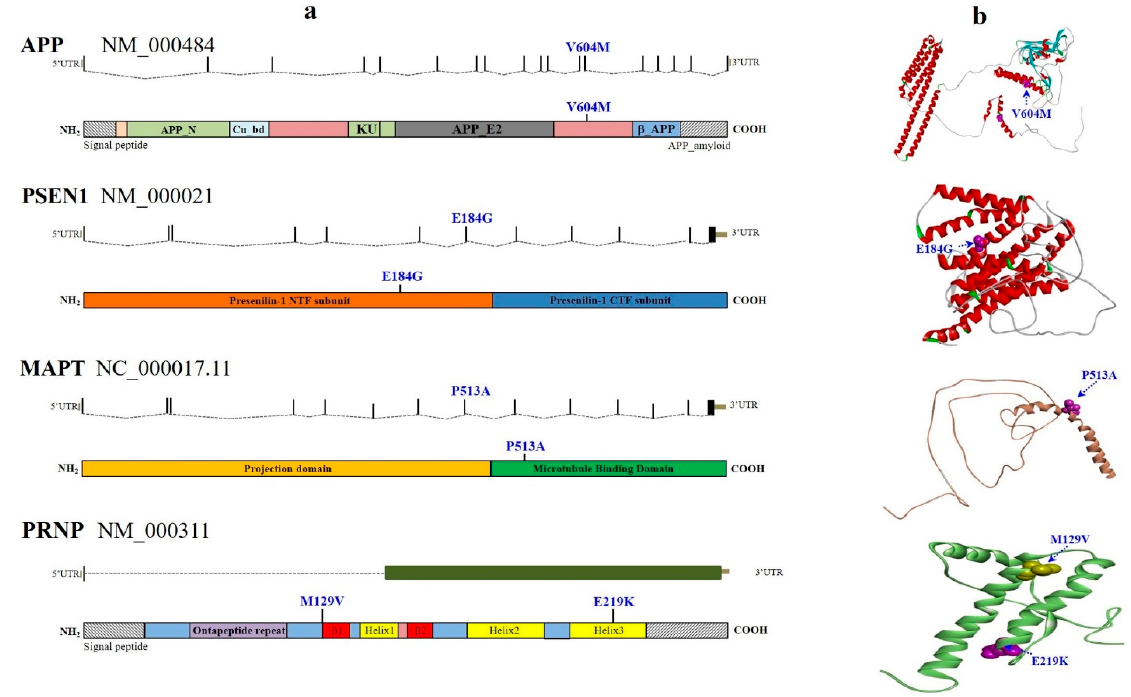
Figure 1. Schematic representation of the missense mutations in definite early-onset Alzheimer’s disease (EOAD) cases. Panel ( a ) shows the position of causative selected-mutations and coding risk variants relative to the respective gene and protein sequences. Panel ( b ) illustrates the position of each mutated amino acid residue relative to the 3D protein or domain structure. APP, Amyloid-beta precursor protein; Cu_bd, copper-binding domain; APP_E2, E2 domain of amyloid-beta precursor protein; KU, Kunitz-type serine protease inhibitor domain; β _APP, Beta-amyloid precursor protein; UTR, untranslated region; APP_N, N-terminal fragment of the β -amyloid precursor protein.